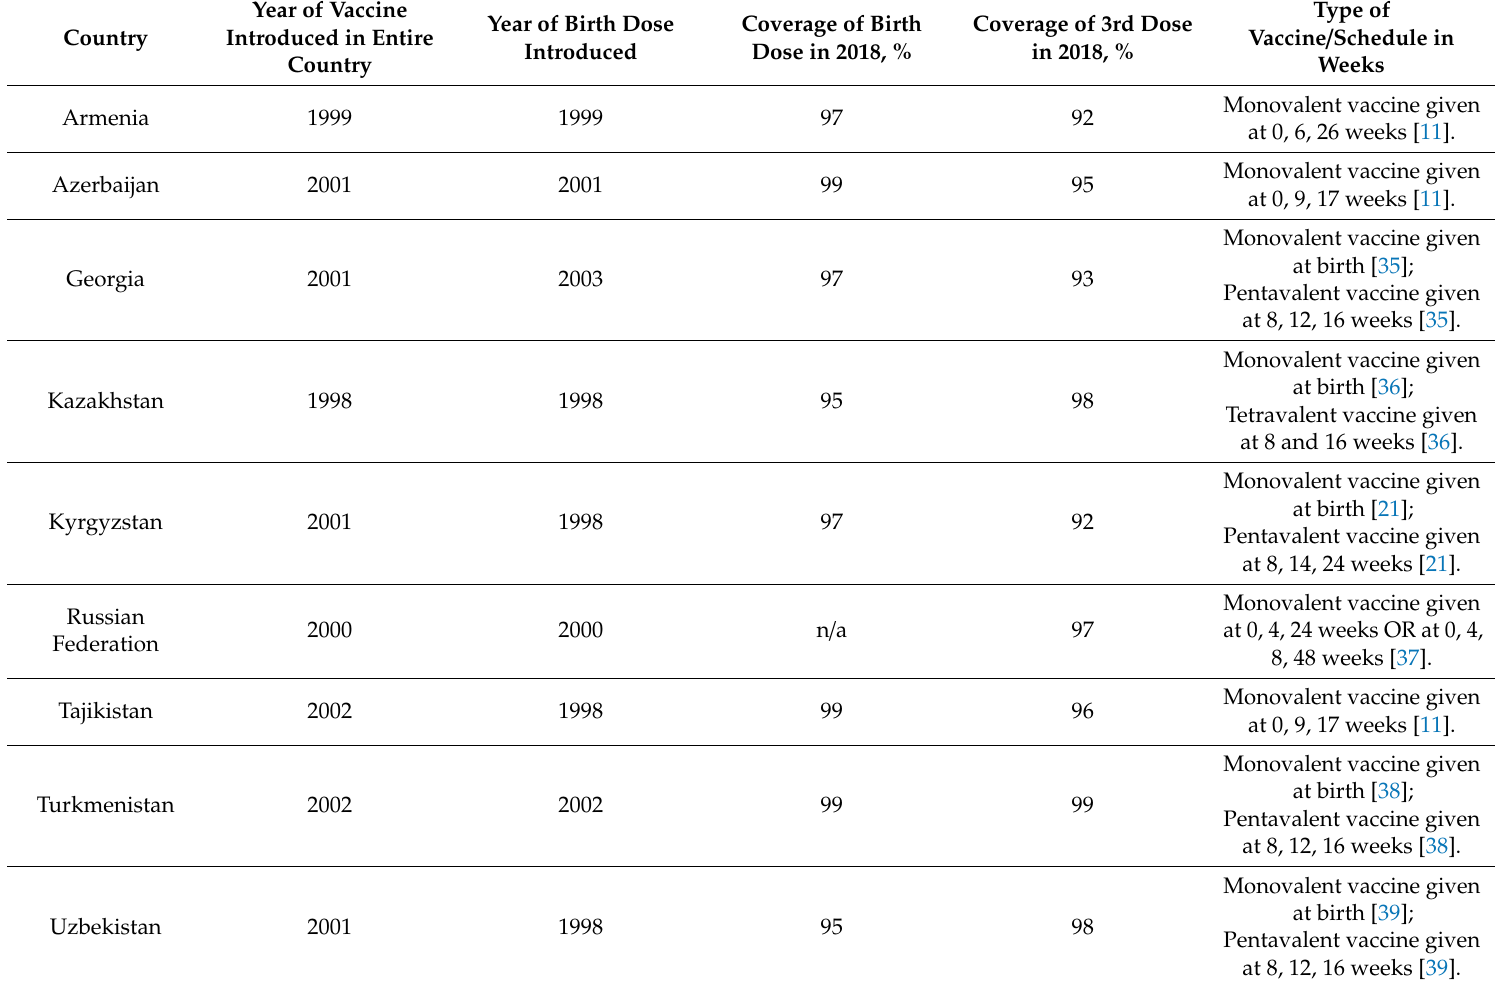
Table 3. Implementation of HBV vaccination in the countries of Central Asia and the Caucasus. All the data were retrieved from the source [34], except for the information on vaccine type and schedule, for which the sources of information are mentioned in